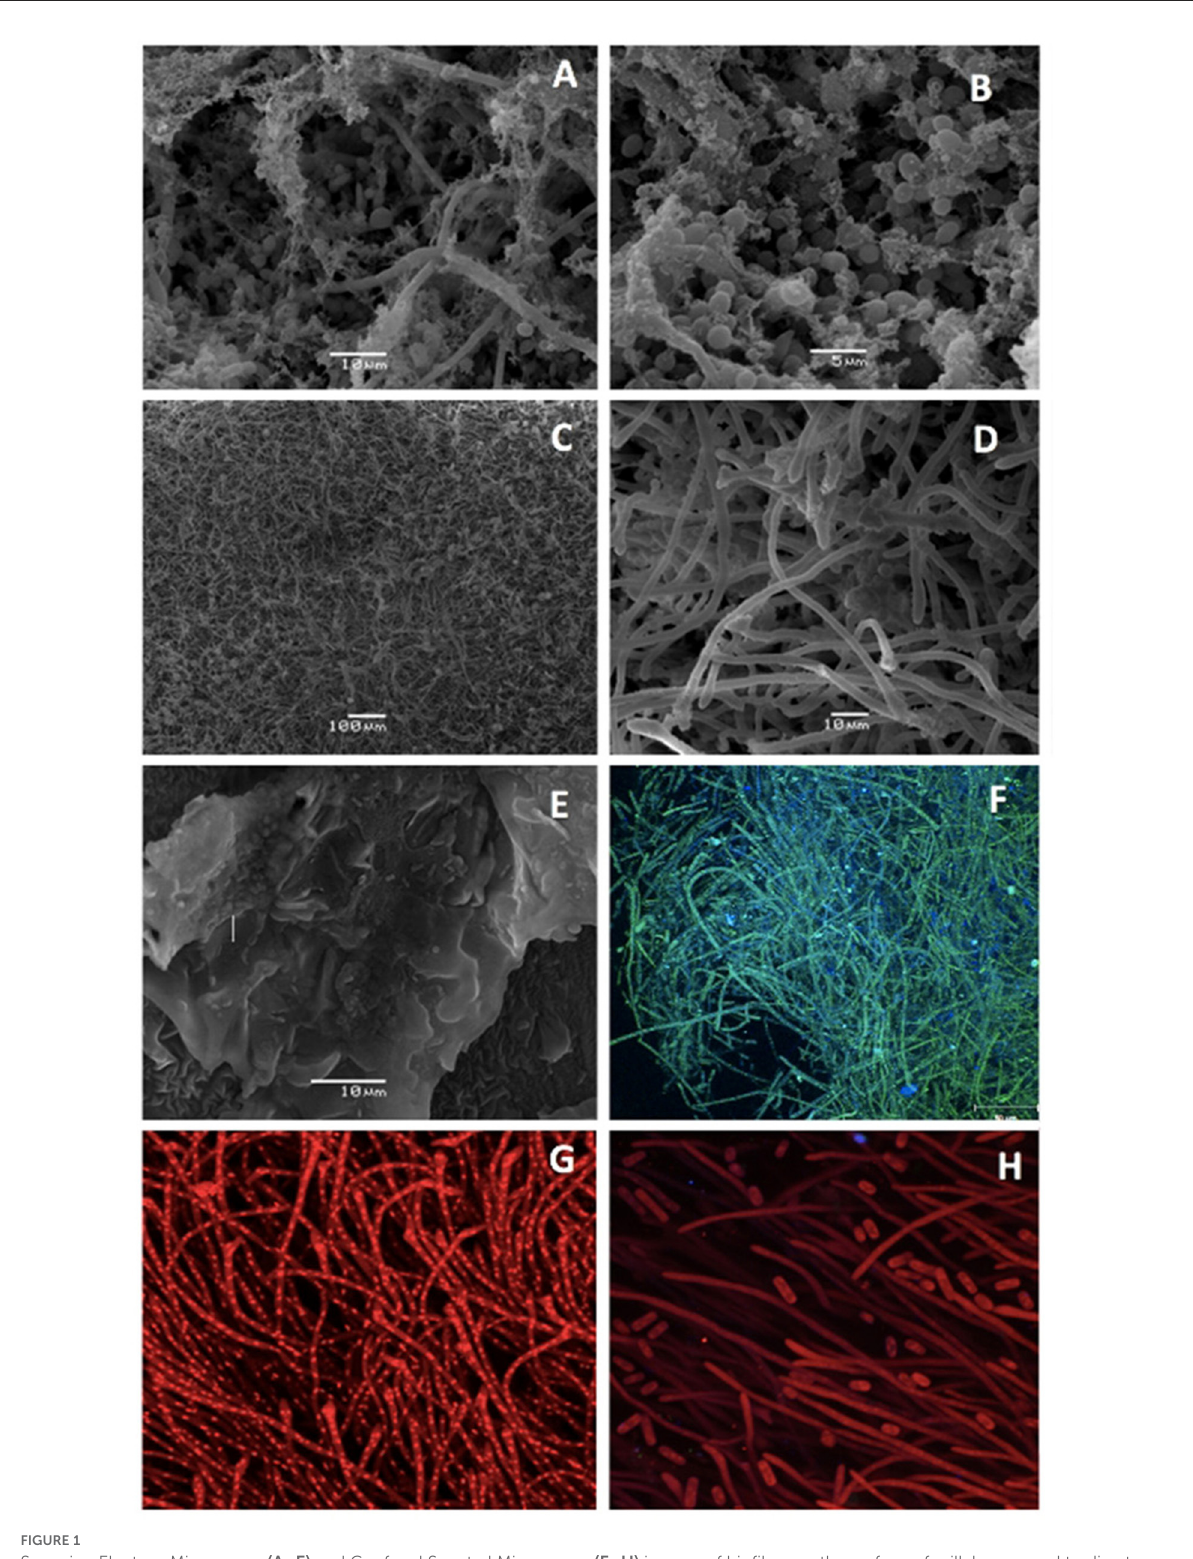
FIGURE1 Scanning Electron Microscopy (A–E) and Confocal Spectral Microscopy (F–H) images of biofilms on the surface of milk hoses used to divert milk on three dairy farms: Farm A (A,B,F) , Farm B (C,D,G,H) , and Farm C (E) . Panel (F) shows a multispecies biofilm analyzed using Nomarsky microscopy (405/488nm) and Panels (F,G) show a biofilm stained with Propidium Iodide